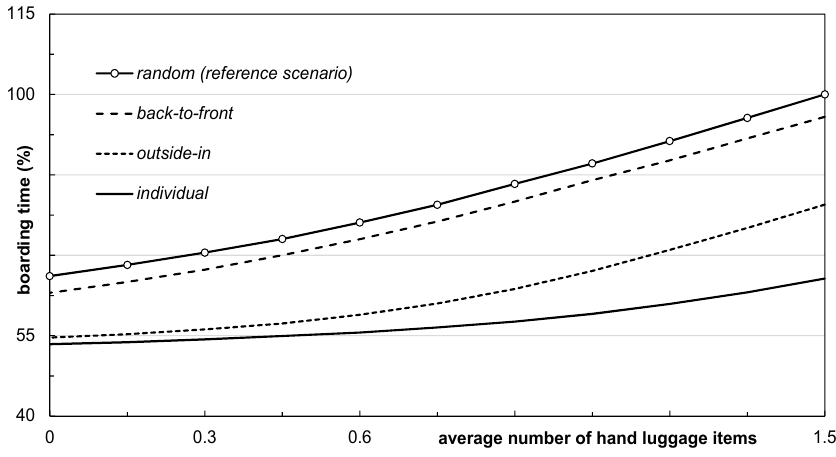
Figure 12. Boarding time of different boarding strategies with decreasing hand luggage items.